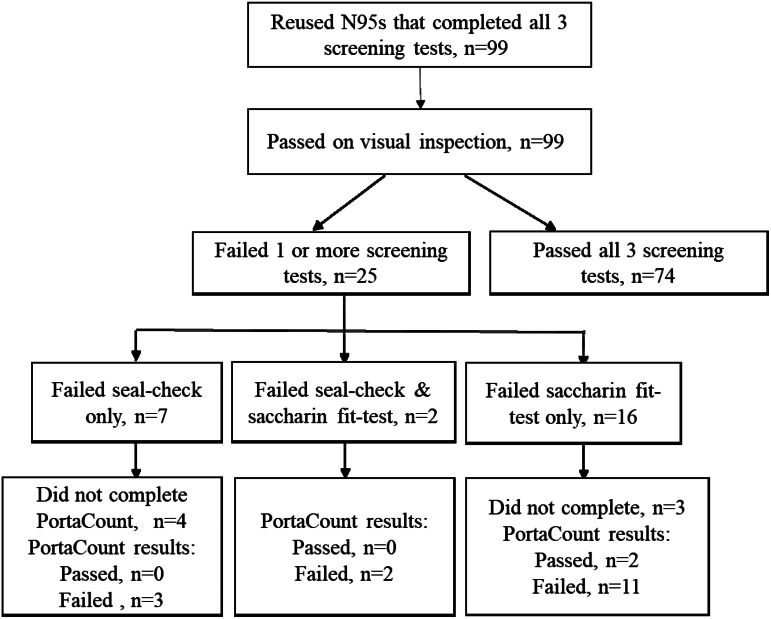
Flow diagram of recruited healthcare workers who reused N95s during the COVID-19 pandemic.